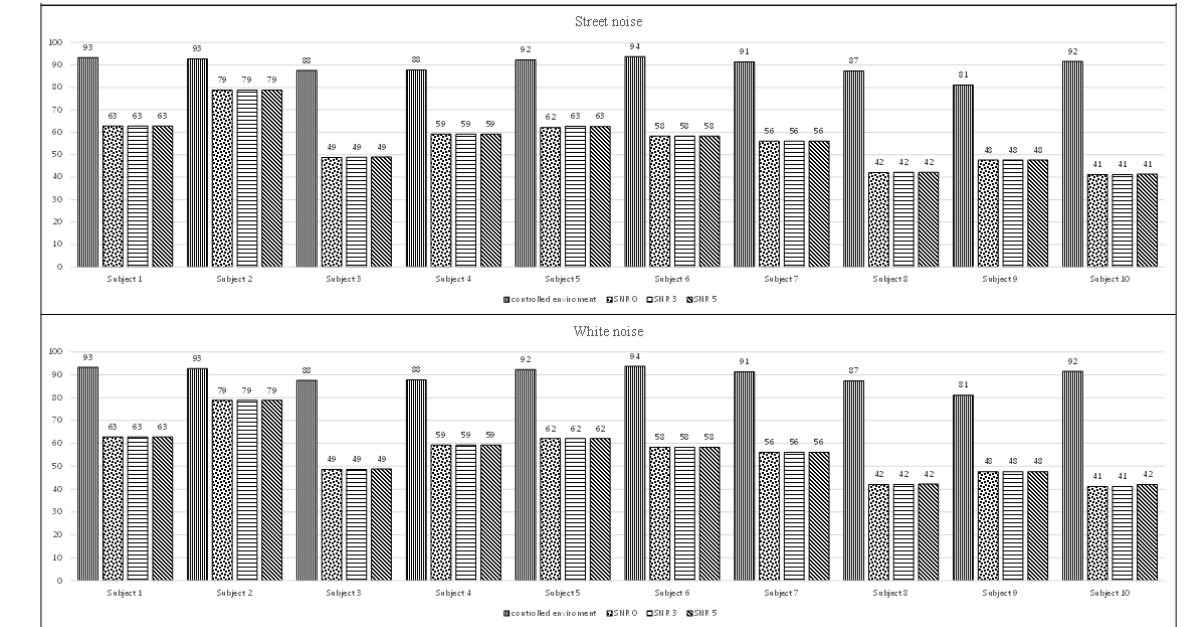
Figure 9. Accuracy of the automatic speech detection system with the presence of 2 different types of background noise (street noise and white noise) at 3 SNR levels. The first bar of each graph indicates the accuracy of the original recording under the controlled environment. SNR: signal-to-noise